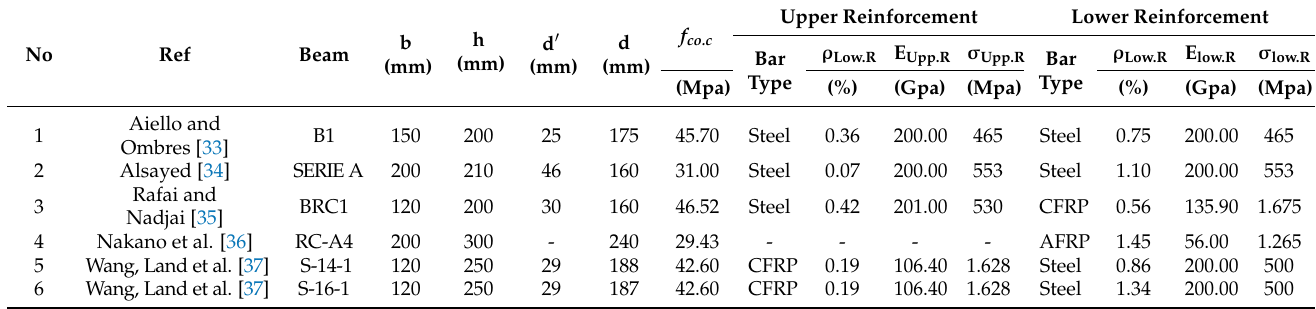
Table 4 provides test data parameters for six rectangular beams: two steel doubly RC